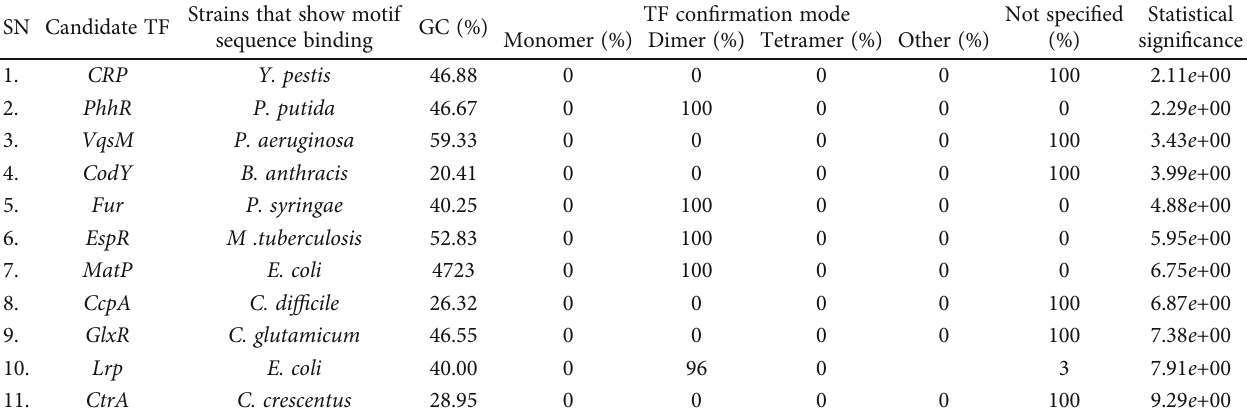
Table 5: List of match candidates of EXPREG transcription Con fi rmation Factor (TCF). Strains that show motif SN Candidate TF sequence